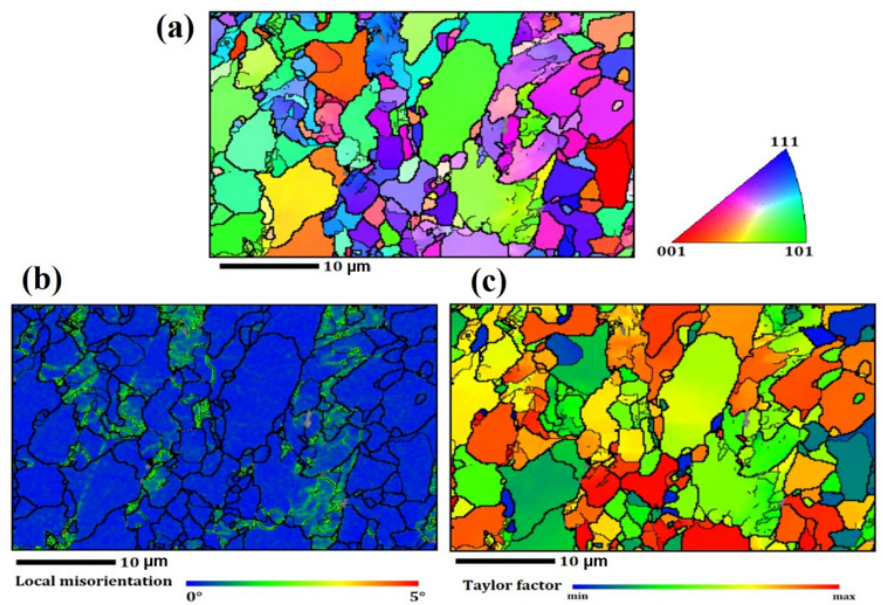
Figure 4. ( a ) Normal direction orientation image, ( b ) Kernel average misorientation, and ( c ) Taylor factor maps of the as-received API X70 steel .